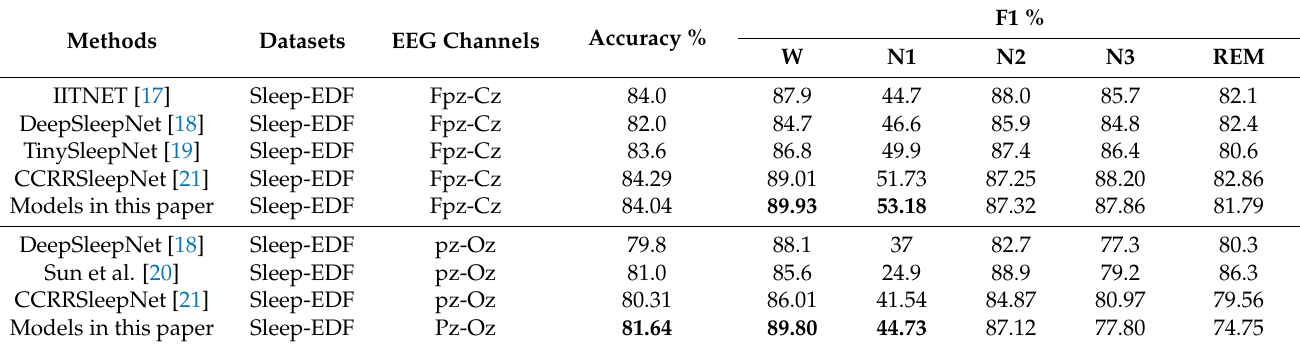
Table 5. Comparison of sleep EEG signal deep learning model and other classification methods based on bidirectional